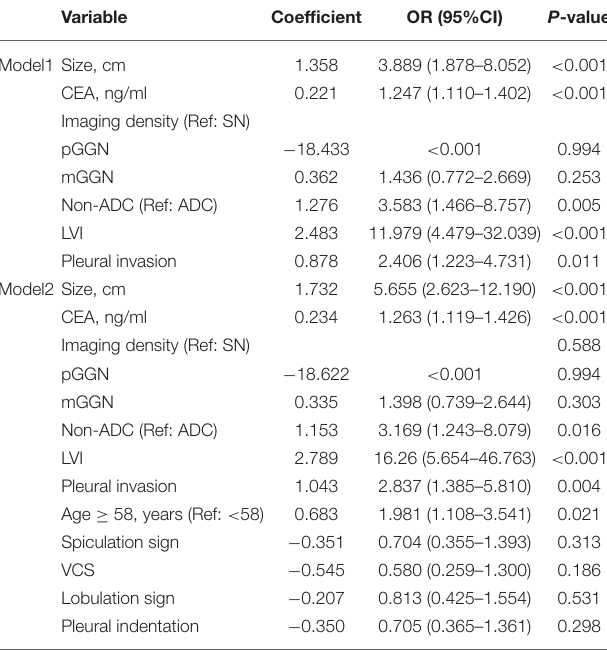
TABLE 2 | The logistic regression models using the selected optimal predictive variables in the training cohort.